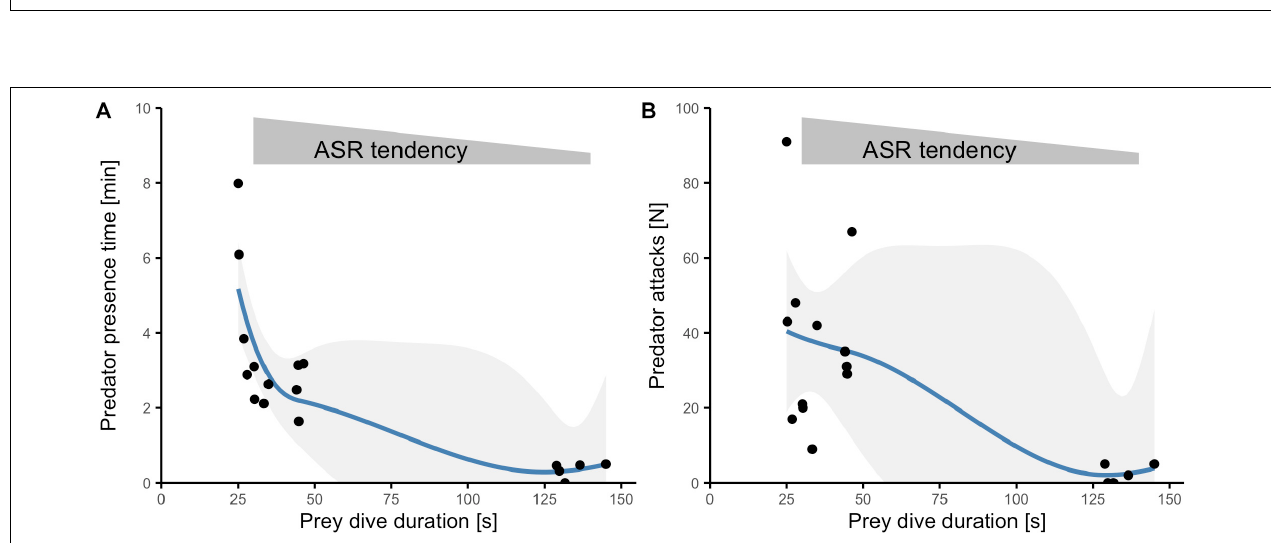
FIGURE 3 | Interplay among prey behavior and predator activity. Relationship between dive duration and either (A) predator presence time (mean) or (B) predator attacks (total sum) at different daytime periods. Each point represents data for one sampling occasion (sample-pooled measurements). Blue lines represent loess-smoothed curve fits with 95% CI for significant Kendall rank